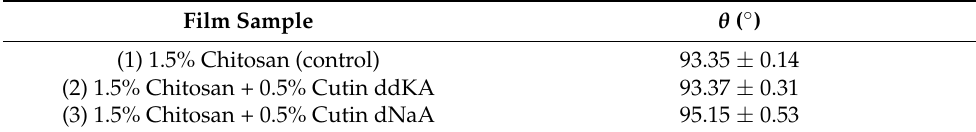
Table 12. Static water contact angle values ( θ , ◦ ) of the film samples.